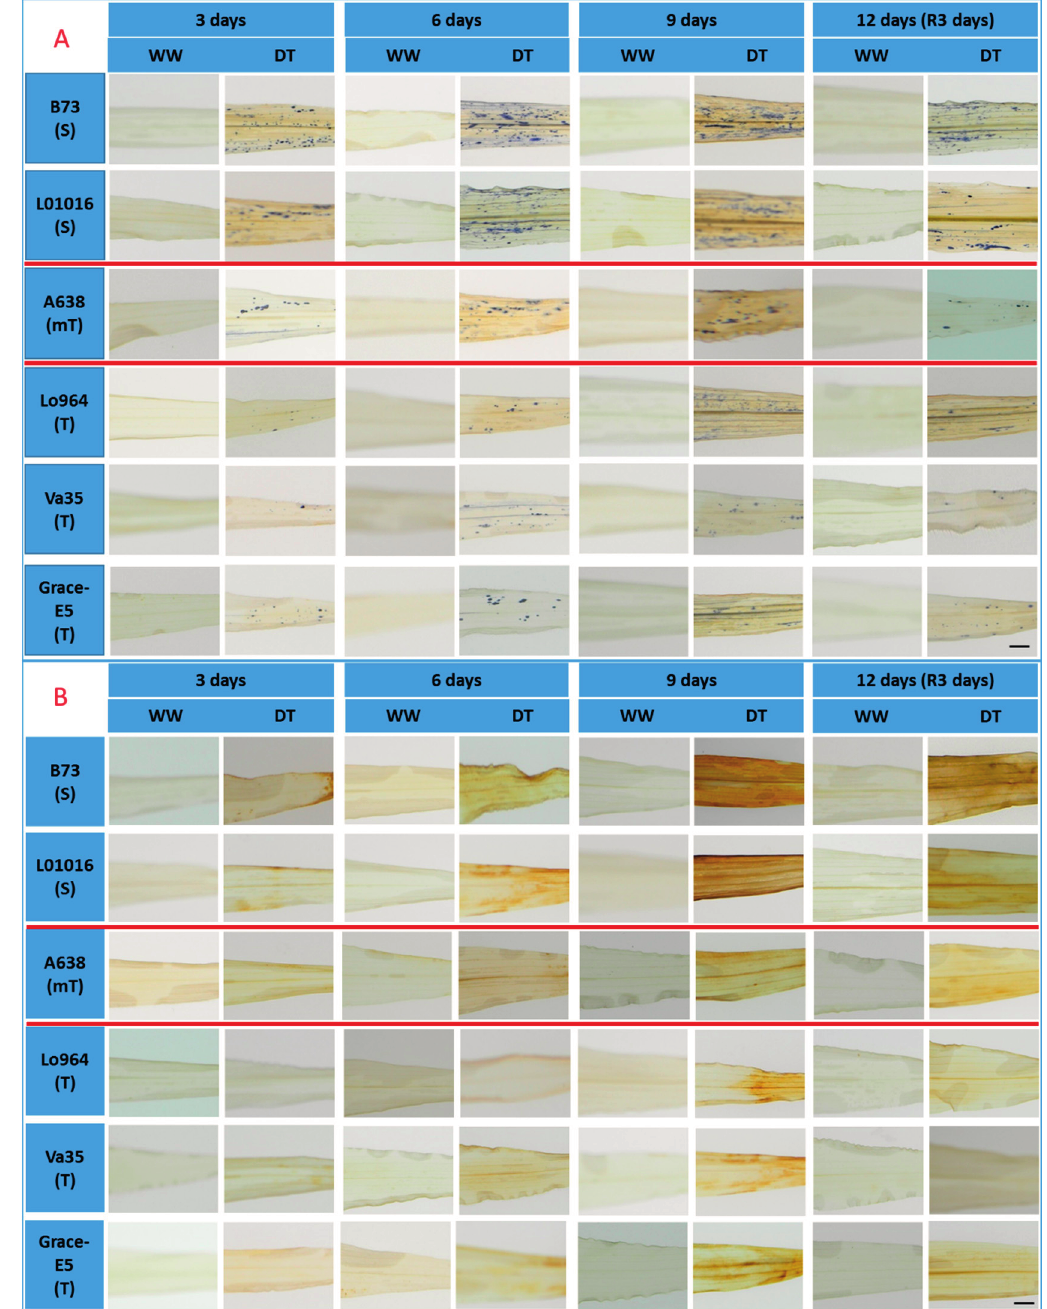
Figure 3. Visualization of superoxide radical and hydrogen peroxide in the leaves of maize plants under well-watered (WW) and drought stressed (DT) conditions. Endogenous O 2 · − levels were monitored by staining O 2 · − using a Nitro blue tetrazolium (NBT) staining method ( A ); and the endogenous H 2 O 2 level was monitored by staining H 2 O 2 using 3,3 ′ -diaminobenzidine tetrahydrochloride hydrate (DAB) ( B ). Scale bar in ( A , B ), 5